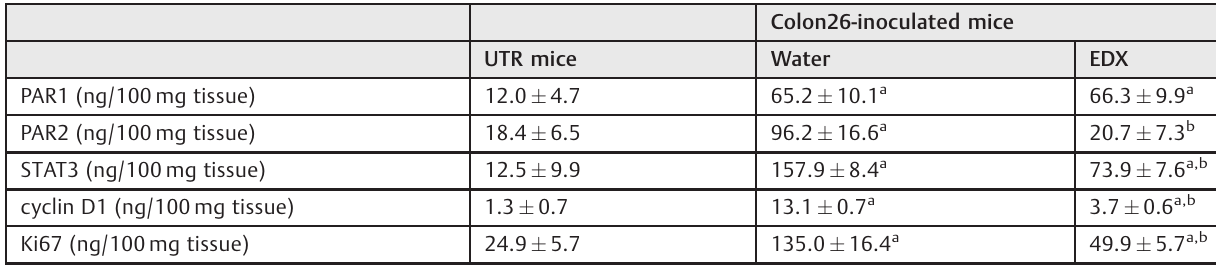
Abbreviations: PAR1, protease-activated receptor 1; PAR2, protease-activated receptor 2; STAT3, signal transducer and activator of transcription-3. Note: Tissue levels of PAR1, PAR2, STAT3, cyclin D1, and Ki67 were determined using factor-speci fi c ELISA. a Signi fi cant difference from the UTR mice group ( p < 0.01). b